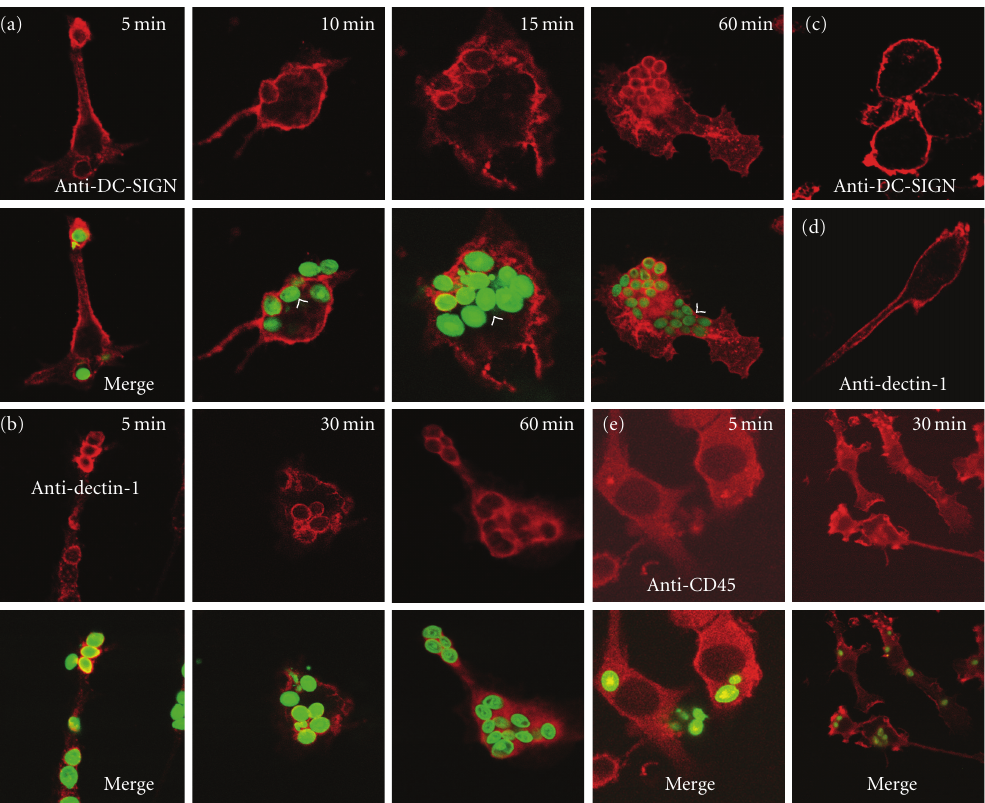
Figure 5: DC-SIGN and dectin-1 cluster around zymosan particles. DC at a concentration of 5 · 10 5 cells/ml were layered over glass coverslips and incubated with Alexa-Fluor 488 (green) labeled zymosan particles (5 particles per cell) for di ff erent times at 37 ◦ C. Anti- DC-SIGN mAb and goat anti-mouse IgG Ab labelled with Alexa-Fluor 594 (red) were used for staining DC-SIGN. Note that upon zymosan stimulation, DC-SIGN clusters around zymosan, but not around engulfed particles inside the cell (arrowheads) (a). DC were treated with anti-dectin-1 mAb and goat anti-mouse IgG Ab labelled with Alexa-Fluor 594 (b). Cells incubated in the absence of zymosan particles were stained for DC-SIGN and dectin-1 (c, d). Cells incubated in the presence of zymosan particles were assayed for CD45 staining at the times indicated (e). Reproduced with permission